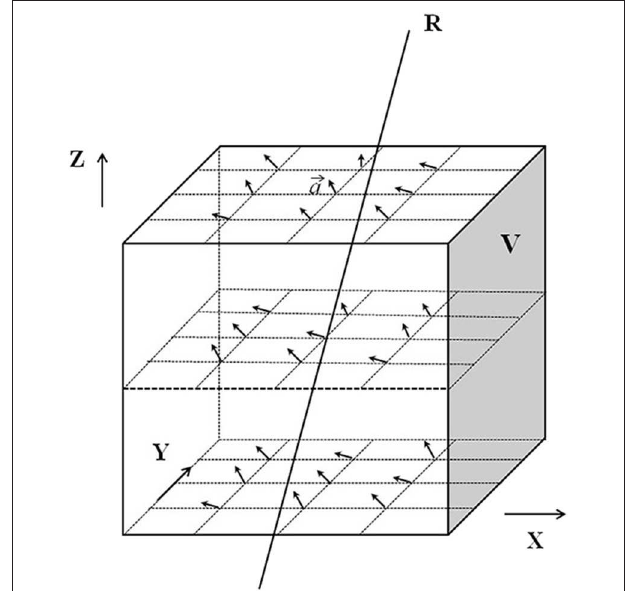
FIGURE 2 | Schematic diagram of obtaining the two-dimensional deformation vector. V represents the ROI set by the X, Y, and Z axes of the coordinate system. The arrows in the ROI V represent the 3D deformation vector “ each pixel in the ROI.